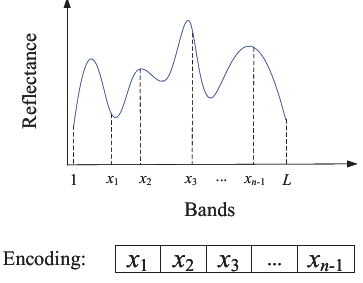
Figure 2. Boundary encoding